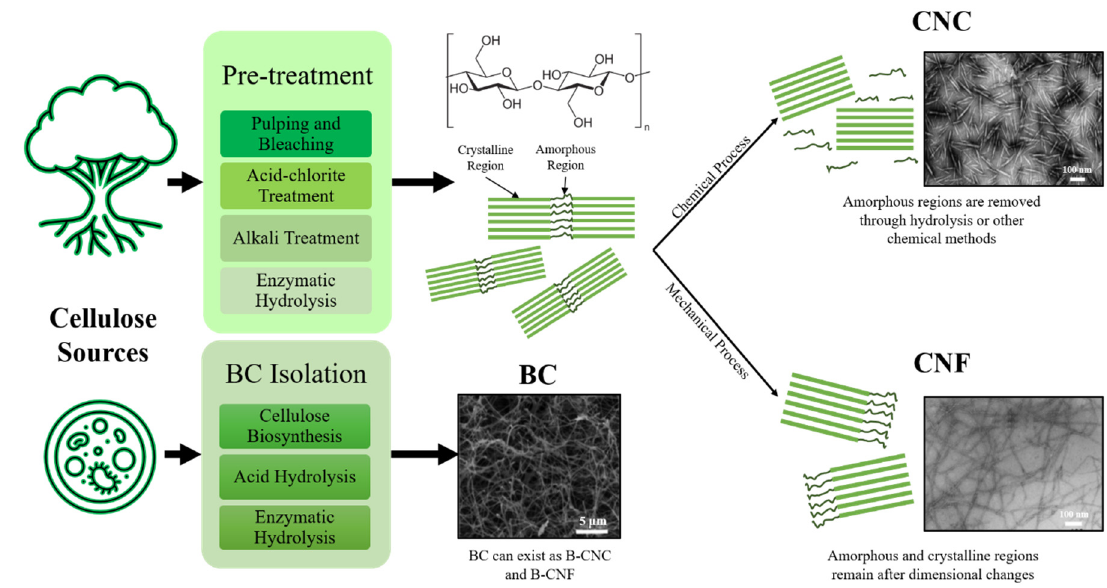
Figure 5. General process flow of isolating cellulose nanocrystals (CNCs), cellulose nanofibers (CNFs) and bacterial celluloses (BCs) from cellulose sources. TEM micrographs adapted with permission from [69]. Copyright 2016 Elsevier.